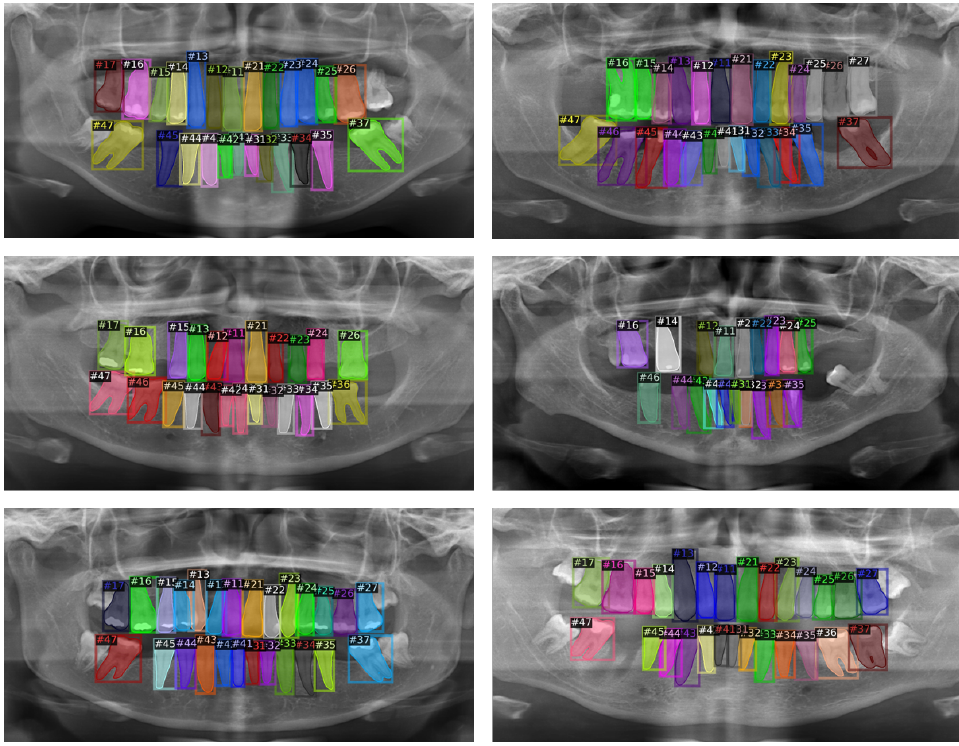
Figure 5. Visualization of tooth instance segmentation model result.